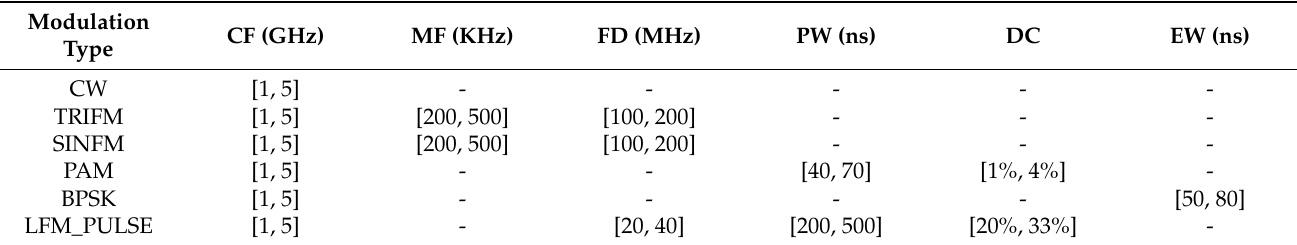
Table 3. The parameters of different radiation source signals.